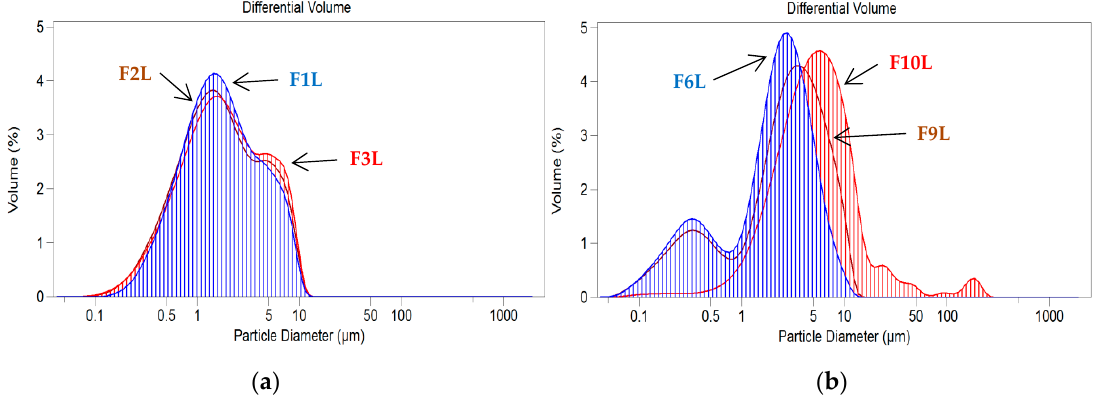
Figure 2. Particle size distributions in SLM formulations with Compritol ( a ) and stearic acid ( b ): placebo (F1L and F6L), with cyclosporine (CsA) (F2L and F3L) and with spironolactone (SPIR) (F9L and F10L).